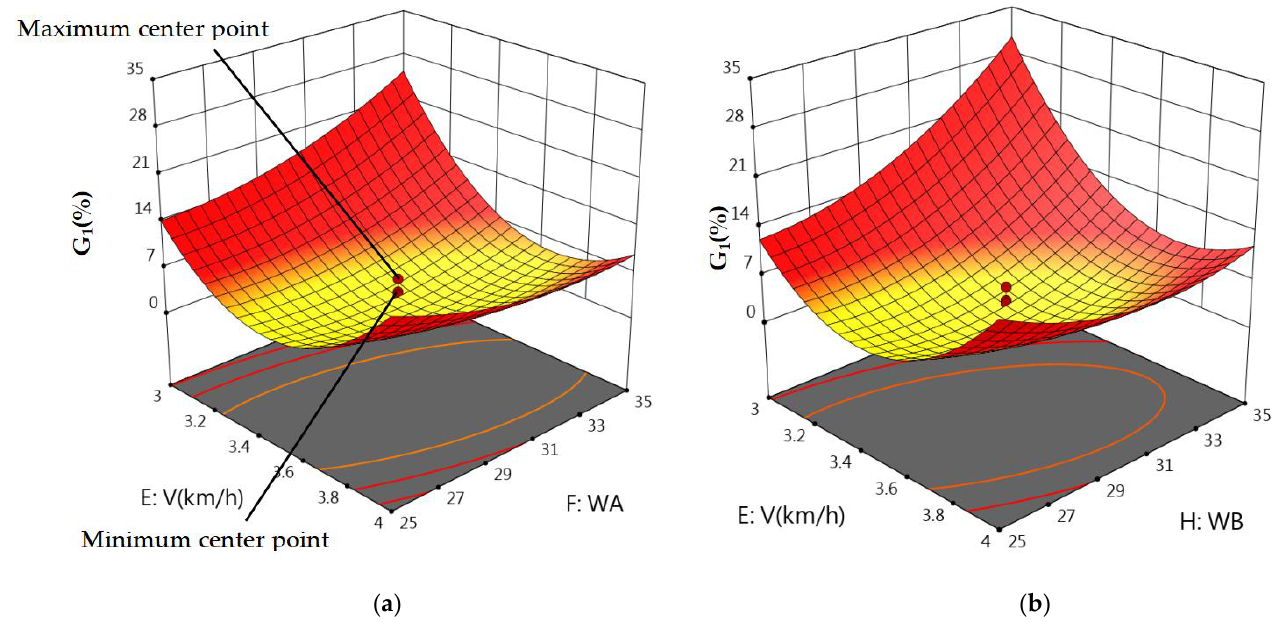
Figure 9. ( a ) EF factor interaction surface. ( b ) EH factor interaction